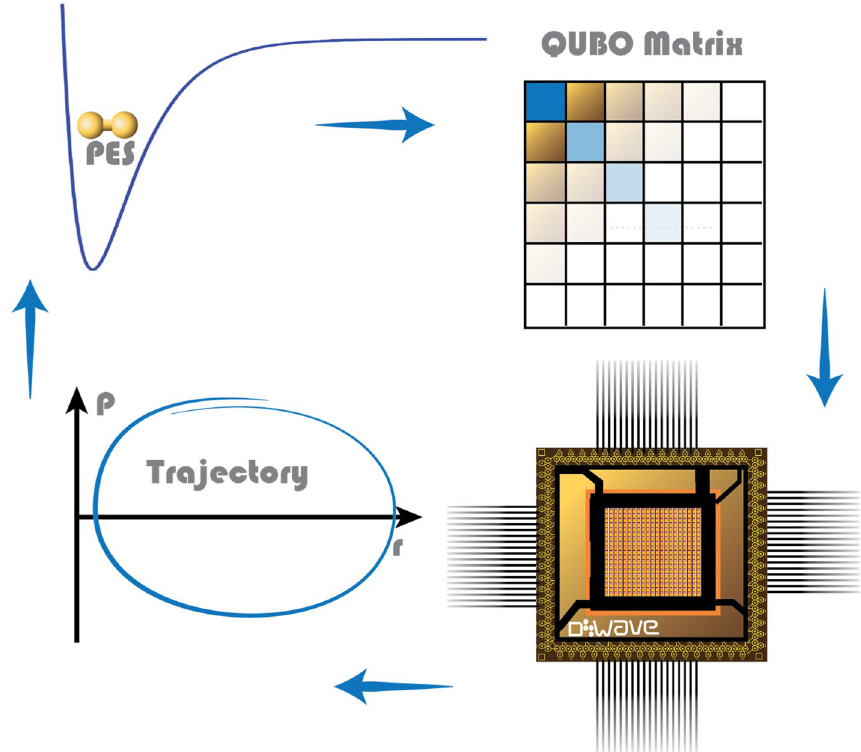
Figure 1. Schematic representation of the workflow of